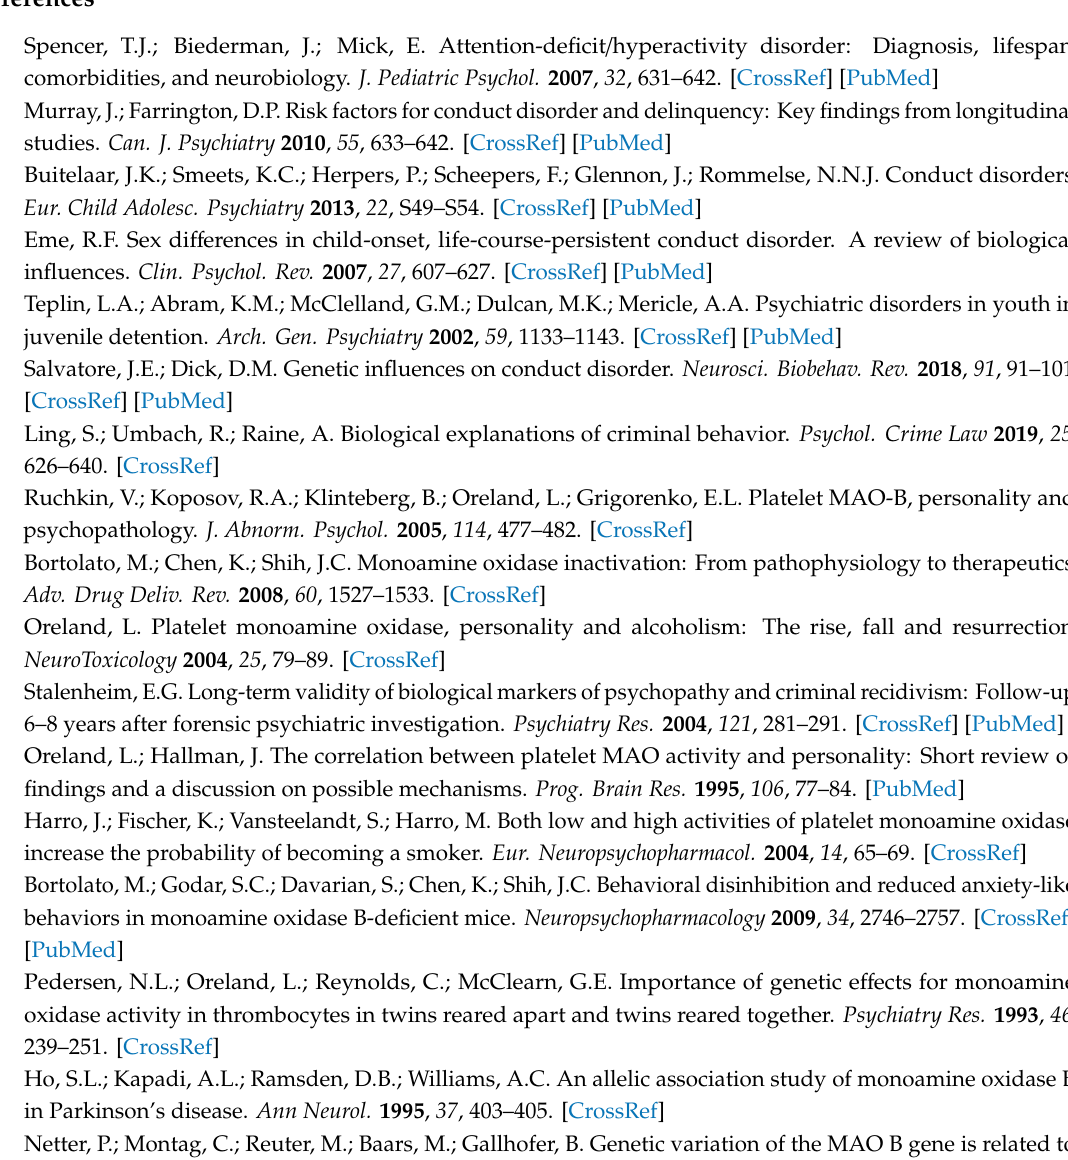
Figure S1. Graphical representation of the results obtained after MAOB rs1799836 genotyping with real-time